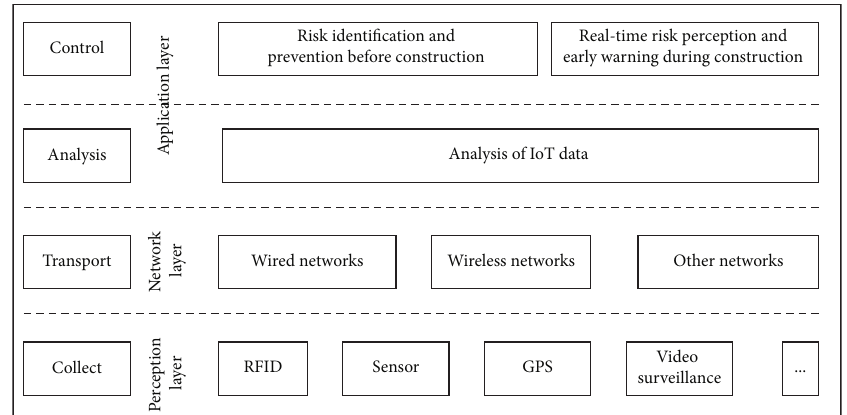
Figure 3: Highway engineering construction safety risk control system.